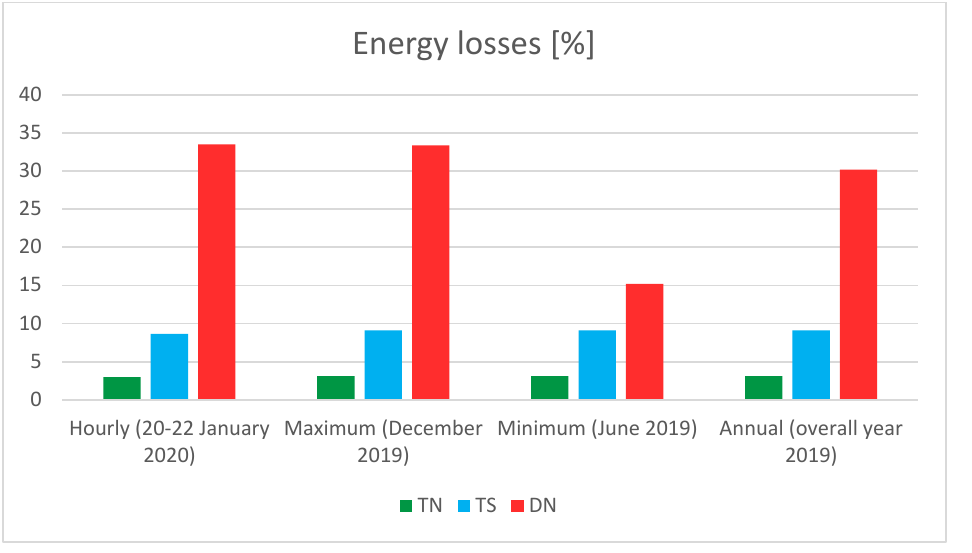
Figure 15. Energy losses in transmission network, thermal stations and distribution network For all the highlighted components (TN, TS, DN), the energy losses exceed the rated values [35] and usual values [28,36]. The worst component is the distribution network of secondary fluid, having very high losses.